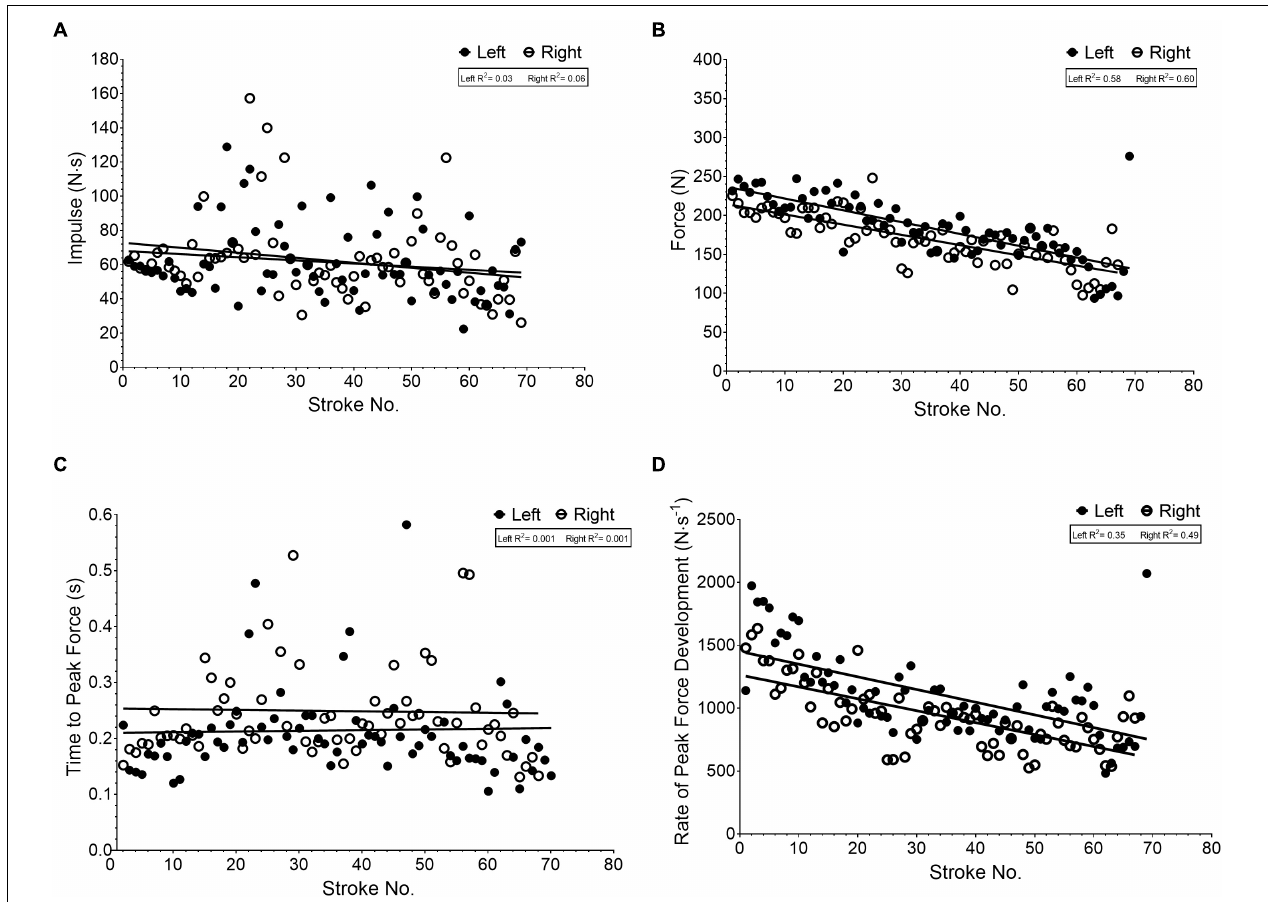
FIGURE 4 | Linear regression for variables of force per left and right stroke [ (A) impulse, (B) peak force per stroke, (C) time to peak force, (D) rate of peak force development] in relation to stroke number during the flatwater race